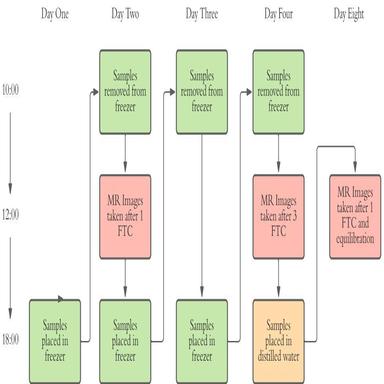
Flow-chart showing protocol used to assess the effect of 3 repeat freeze thaw cycle and equilibration on T2 relaxation time.